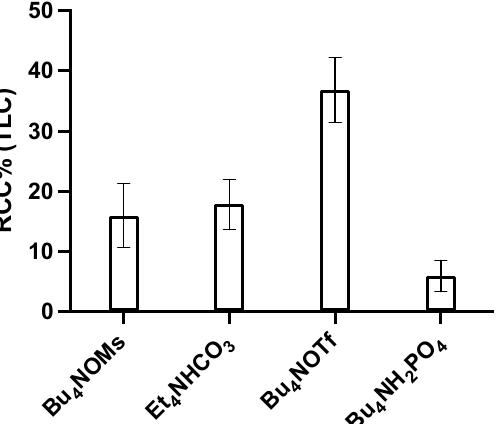
Figure 2. Effect of different elution solutions on the RCC. Reaction conditions: QMA preconditioned K 3 PO 4 0.5 M, [ 18 F]fluoride (~50 MBq) loaded, flushed with 0.5 mL MeOH and eluted with one of the eluents shown in the x-axis (20 mM) in MeOH 1 mL. Dried under nitrogen gas for 5 min at 100 ° C before adding precursor 3-(3-trimethyltin)-1,2,4,5-tetrazine ( 2 ) (3.2 mg, 10 µmol) and Cu(OTf 2 )Py 4 (10 mg, 15 µmol) in 0.5 mL DMA, 5 min at 100 ° C. The crude reaction was analyzed by radio-TLC and radio-HPLC (SI, Table S1, Figures S1 and S2). n = 3, error bars = standard